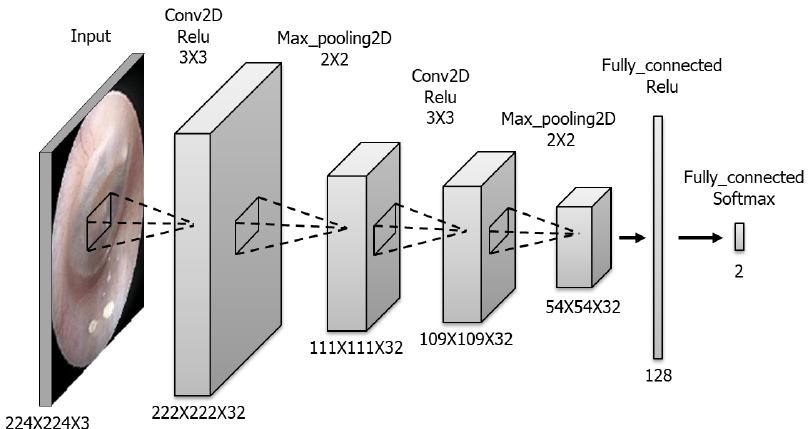
Figure 1. Composition of the CNN model. This model consists of two convolutional layers, two max pooling layers and two connected layers.